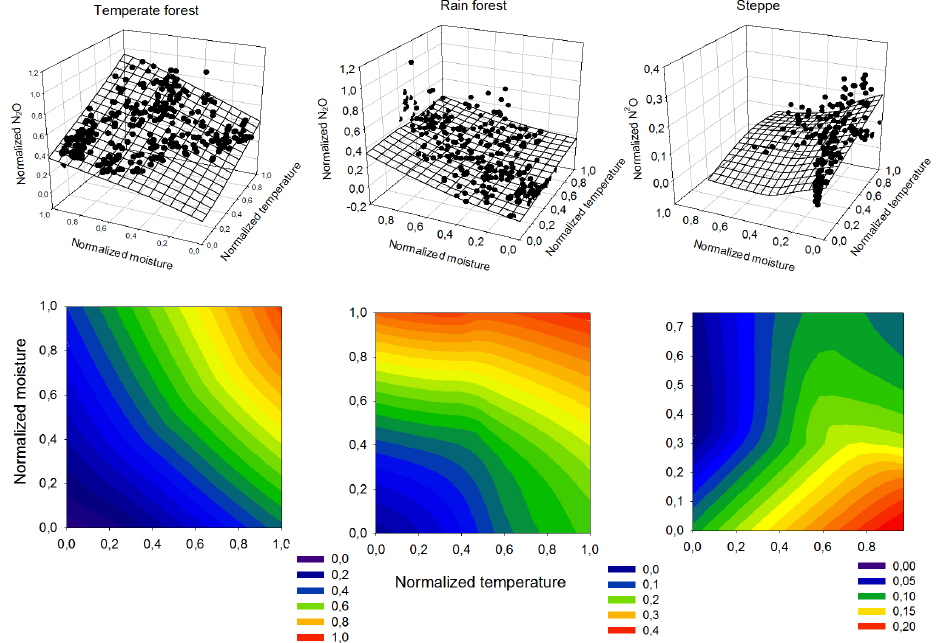
Fig. 7. Temperature and moisture effects on soil nitrous oxide fluxes for the three different ecosystems (temperate forest, semi-arid steppe, and tropical rain forest). For this analysis nitrous oxide fluxes, soil temperature, and moisture data were normalized at site scale to a range of 0–1 (0: lowest observed value; 1: highest observed value). Nitrous oxide data for the H¨oglwald Forest were randomly selected from observations in the years 1995 and 1997, though for this analysis nitrous oxide fluxes during the freeze–thaw period was excluded. Prior to the calculation of contour lines, data were smoothed with the loess algorithm (sampling proportion = 1).